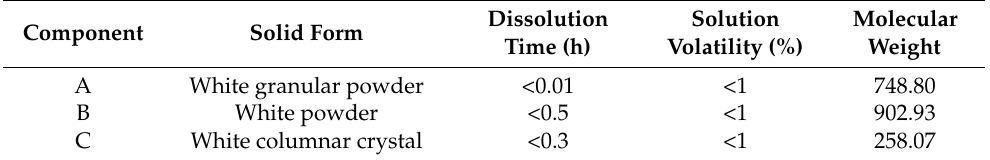
Table 2. Properties of the reinforcement materials.